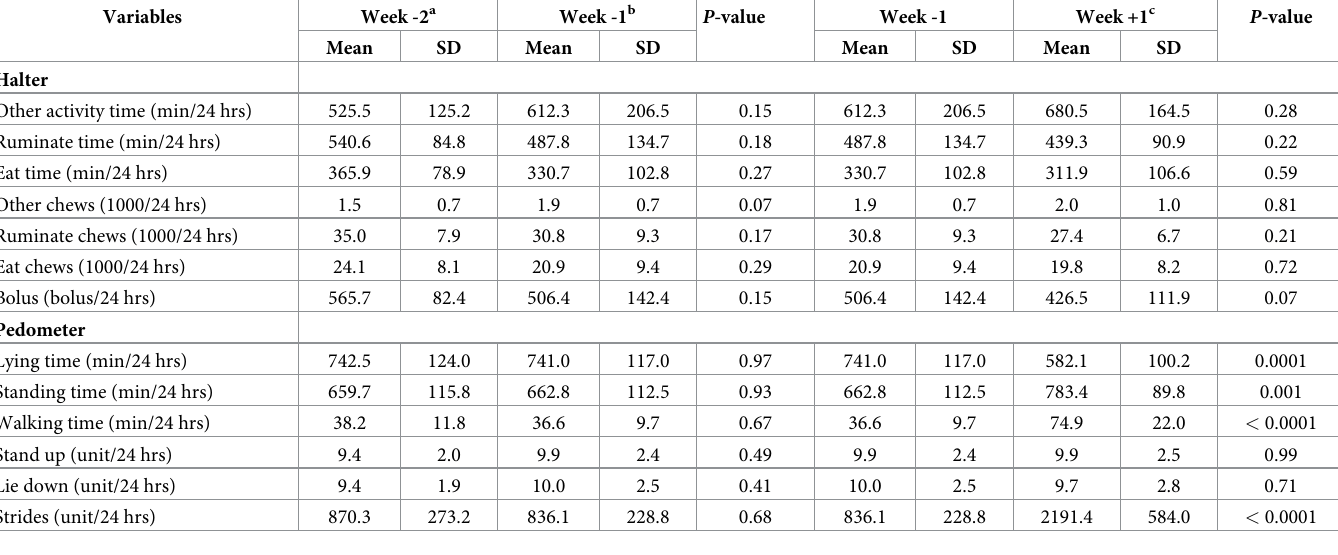
lar, 8’118’240 and 6’088’680 min were obtained by RWh and RWp, respectively. Regarding the behavioral intragroup differences between weeks (wks -2, -1 and +1), the overall mean values for feeding, ruminating and locomotion behaviors of both groups S and H, are given in detail in Table 2A and 2B, respectively (descriptive data). Briefly, feeding, ruminating and locomotion behaviors did not differ between weeks -2 and -1 for both groups. In group-H, feeding and ruminating behaviors did not differ between wk -1 and wk +1. The locomotion behaviors standing time , walking time , and strides were